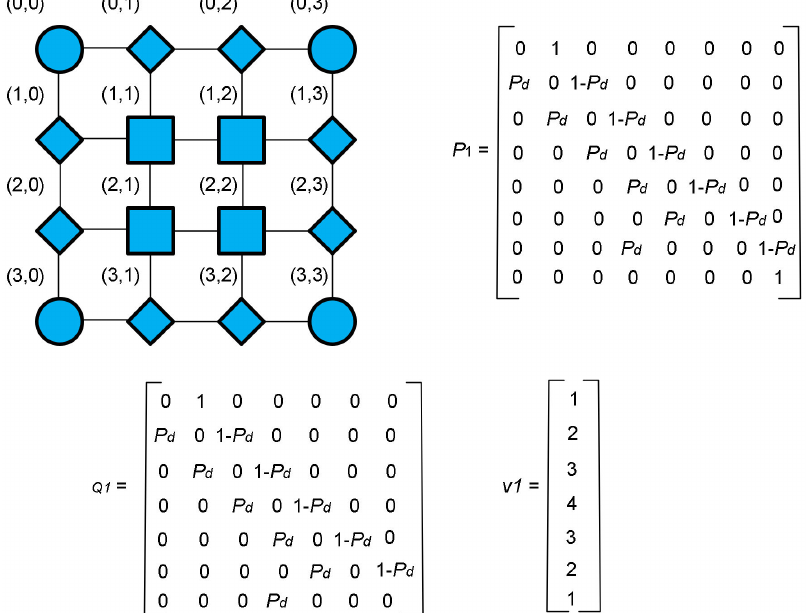
Figure 3. P and Q matrices for nodes marked as circles and corresponding node distances vector v 1